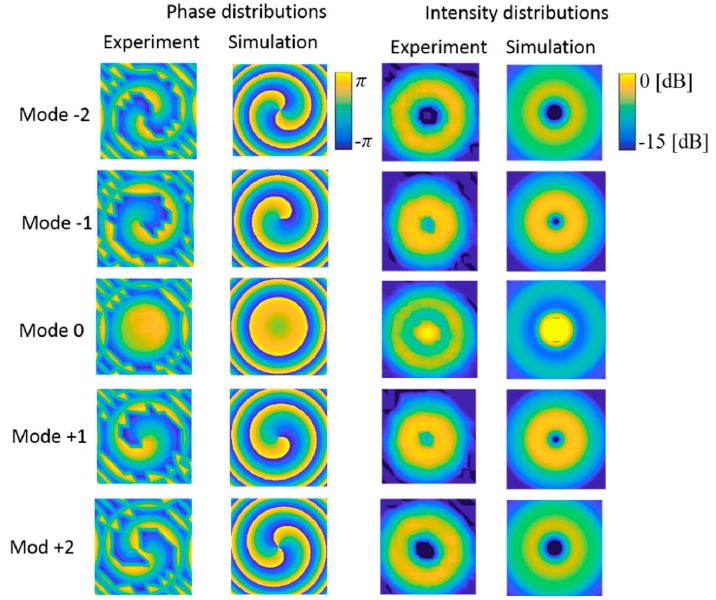
Figure 5. Measurement results and simulation results of phase and intensity distributions.